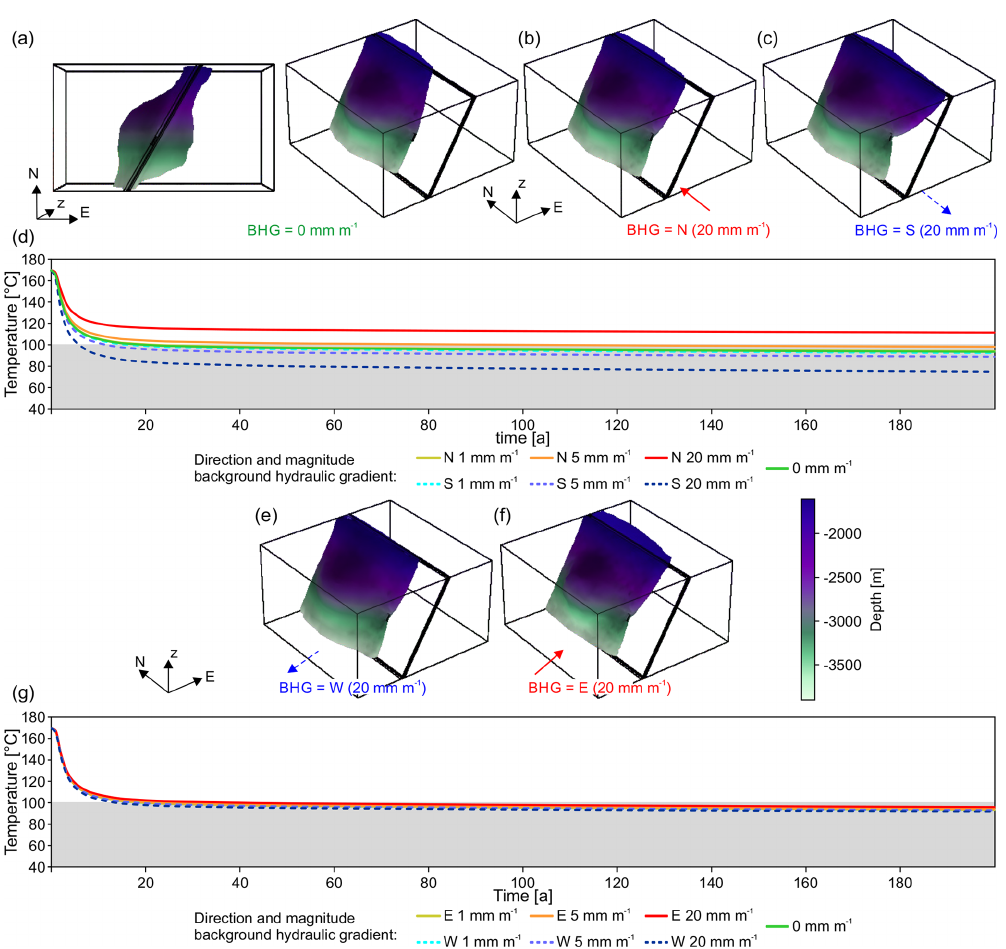
Figure 6. Temperature development and shapes of the HDI for faults that consist of a damage zone. In panels (a) , (b) , and (c) , the shapes of the HDI after 100 years for fault-parallel BHGs are shown. The HDI is in large parts restricted to the damage zone but expands around the injection well into the host rock. Panels (d) and (g) show the temperature developments over time of the produced fluid and contain the results of 13 individual simulations. Panel (d) shows that the production temperatures, independent of BHG, drop sharply in the first 10 years and become independent of BHG, almost stable after about 20 years. Notably, the differences between the different BHGs are comparatively small. In (e) and (f) , the shapes of the HDI for BHGs normal to the strike of the fault after 100 years. (g) The temperature developments for eastwards- and westwards-oriented BHGs are almost